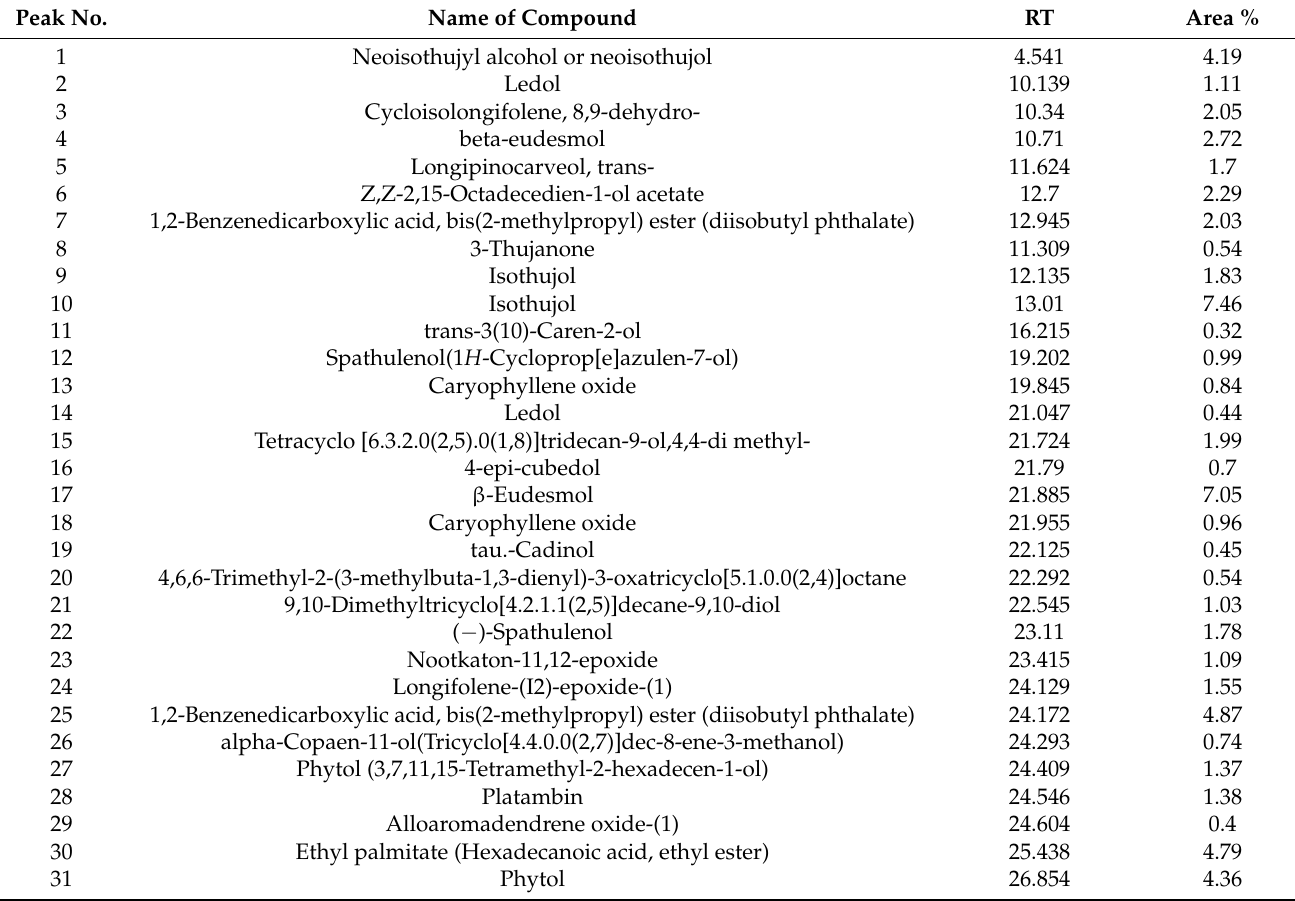
Table 1. GC-MS analysis of terpenoid subfraction of hexane fraction of ethanolic extract of A. nilagirica . Peak